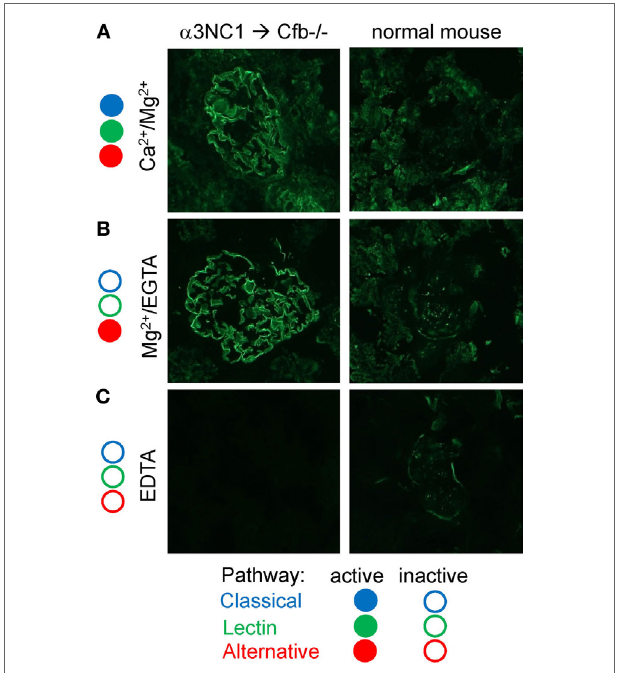
FigUre 9 | In vitro complement activation by glomerular immune complexes from α 3NC1-immunized Cfb − / − mice. Immunofluorescence analysis of C3c deposition onto kidneys cryosections from α 3NC1-immunized D1.Cfb − / − mice (left) and control non-immunized wild-type DBA/1 mice (right), after incubation with 33% normal mouse serum in buffer containing Ca 2 + and Mg 2 + (a) , Mg 2 + and EGTA (B) , or EDTA (c) . Complement pathways active in each buffer are indicated on the left, according to the key shown at the